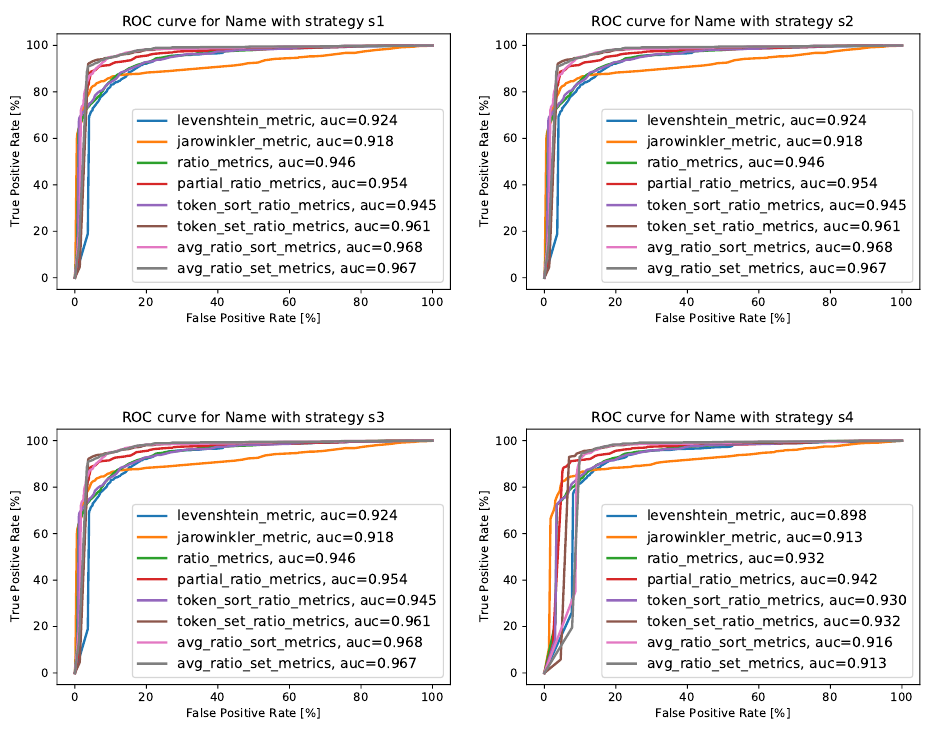
Figure A1. A receiver operating characteristics for all considered string similarity metrics for all four strategies for dealing with missing data for attribute Name .